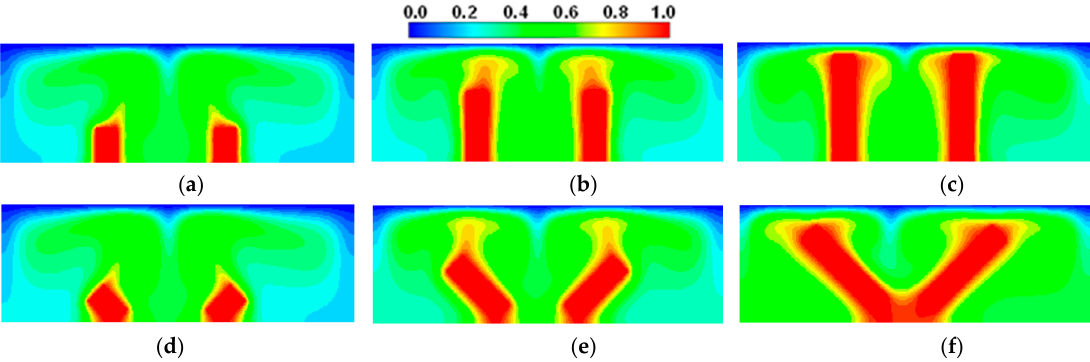
Figure 8. Isothermal contours under the effects of heated-fins lengths with two values of an inclination